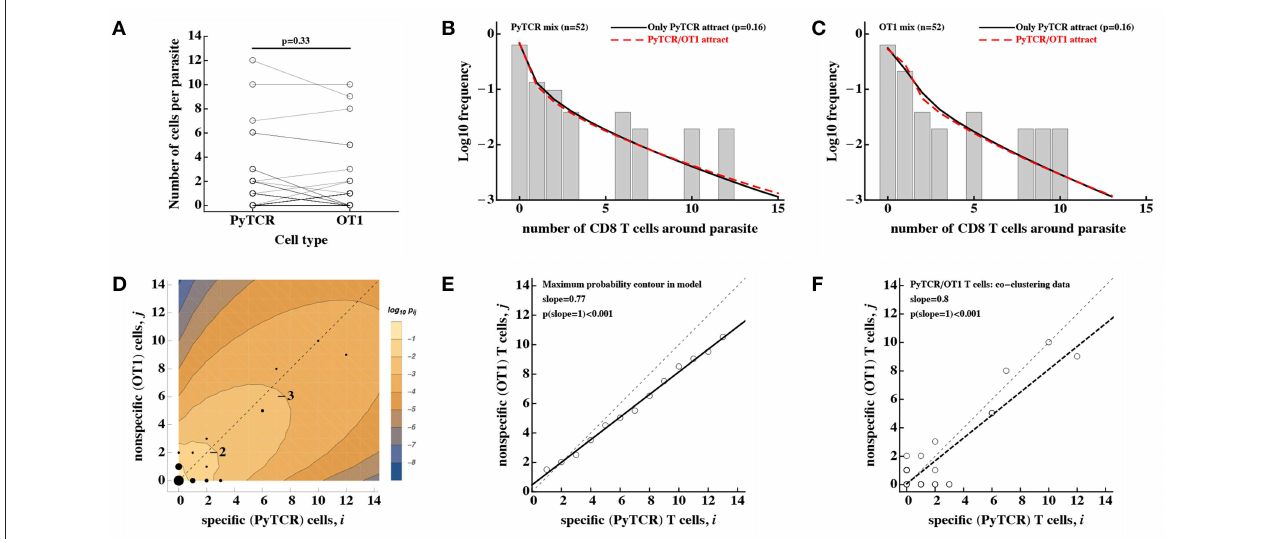
FIGURE 5 | No evidence that activated CD8 T cells of irrelevant specificity play a significant role in cluster formation. Experiments were performed as described in Figure 4A and the number of T cells, specific to Py (PyTCR) and T cells of irrelevant specificity (OT1), found in a 40 µ m radius of n 52 randomly chosen parasites in = the liver was counted using intravital imaging. (A) No difference in the number of Py-specific and non-specific T cells found around Py liver stages (Wilcoxon signed rank test). (B,C) We fitted a series of mathematical models assuming how Py-specific or non-specific T cells mediate attraction to the infection site [co-clustering model, Equations (12–15)], and fits of two models where either only PyTCR T cells attract (solid lines, B,C ) or both PyTCR and OT1 T cells attract (dashed lines, B,C ) as well as data (bars) are shown. A simpler model in which only PyTCR T cells mediate attraction describes the data as well as the more complex model in which both types of T cells attract to the cluster (likelihood ratio test, χ 2 1 1.95, p 0.16). Bars in (B,C) are the observed frequencies of parasites with a variable number of = = PyTCR (B) or OT1 (C) T cells. In (D) we show the data (points) and predictions of the model in which only Py-specific T cells attract all activated cells to the infection site (contours); model prediction is the log 10 P ij (6) where P ij is the probability to observe i Py-specific and j non-specific T cells around the parasite at t 6h after T = cell transfer. The point size represent the number of parasites having a given number of PyTCR/OT1 cells in 40 µ m radius, and thin dashed lines shows the line with j slope 1. In (E) points represent the prediction of the model on the number of PyTCR/OT1 T cells in clusters where P ij reaches maximum for i const (see the = + = contour plot in D ). The solid line represents a regression line for the model predictions with slope 0.76 which is significantly different from 1 ( t -test, p < 0.001) and = the dashed line shows the line with slope 1. In (F) points represent co-clustering data of PyTCR and OT1 T cells around parasites (the same data are shown in D ). = Solid line represents a regression line with slope 0.8 which is significantly different from 1 ( t -test, p < 0.001). Results in (D–F) indicate model-predicted slight bias = toward clustering of a larger number of PyTCR T cells which is not directly observed in the data (A)